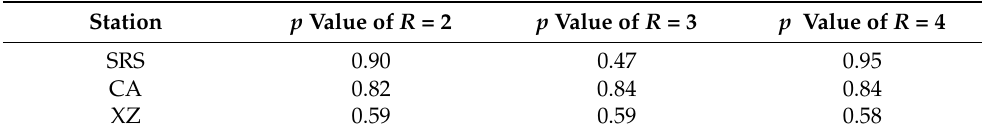
Figure 7. Cascading failure spreading speed analysis of April’s first Wednesday morning peak. ( a ) RA, ( b ) SRS, ( c ) CA and ( d ) XZ. Table 4. Kolmogorov–Smirnov normal distribution test.